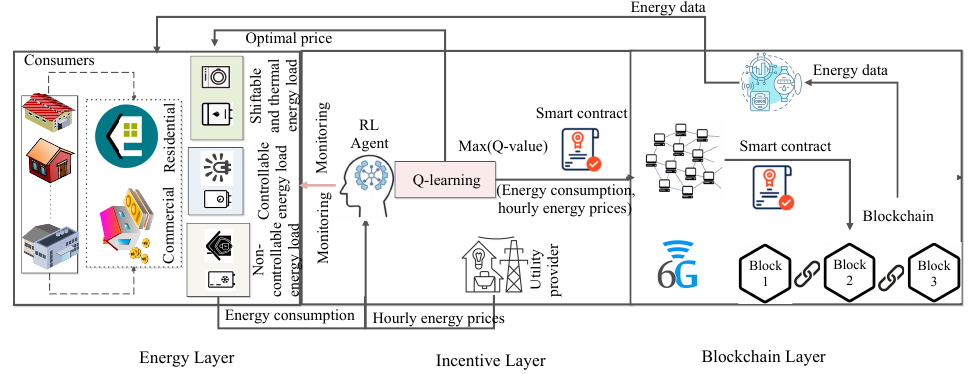
Figure 2. RI-EMS : The proposed approach [27,28]